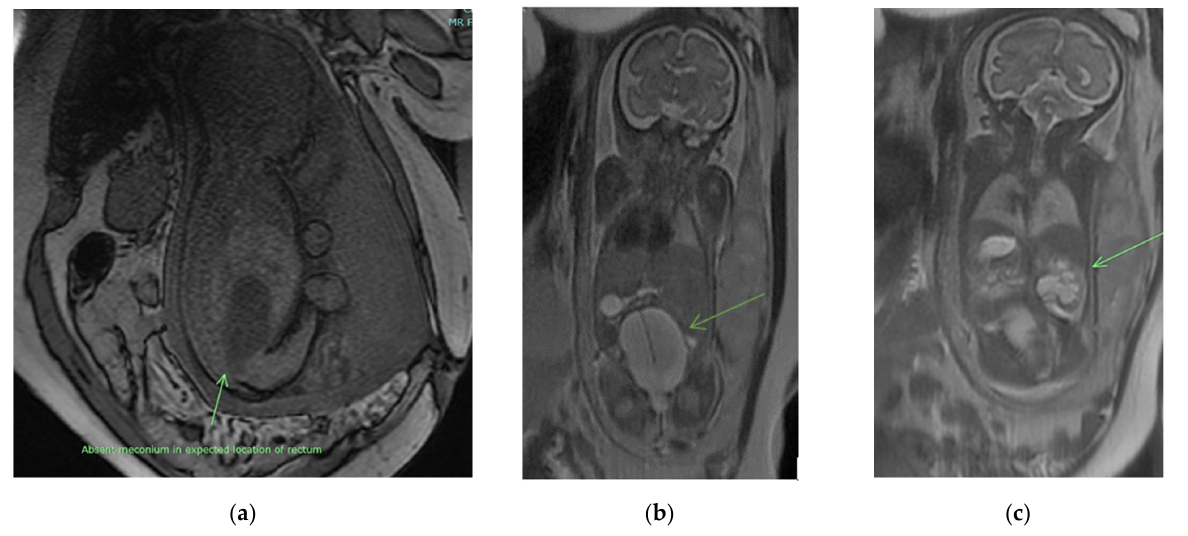
Figure 3. Prenatal MRI findings suggestive of a cloacal anomaly may include (as indicated by arrow): ( a ) absent meconium signal in the expected location of the rectum, ( b ) hydrocolpos with vaginal septum, and ( c ) hydronephrosis.